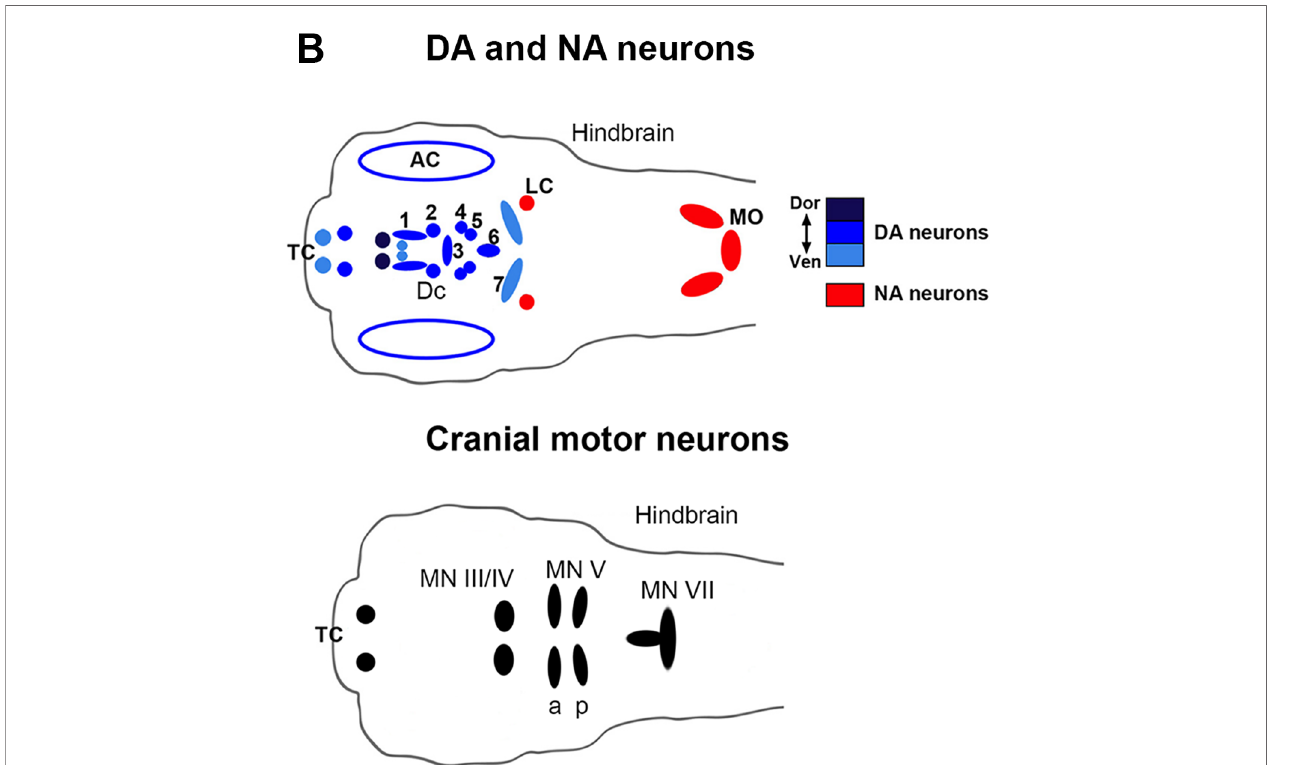
FIGURE 1 | Design of Small Molecule Screen in two phases. (A) Schematic depiction of primary screening and secondary screening procedure. We selected 32 small molecule inhibitors that target chromatin regulators. Zebra fi sh larvae were exposed to the small molecule inhibitors during distinct phases of DA and NA neuron development ranging from 24 to 72 hpf. We screened all compounds at different concentration to fi nd the optimal dosage for each small molecule inhibitor. During the primary screen we evaluated the effects of all selected small molecule inhibitors on DA and NA neurons by whole mount in situ hybridization (WISH) analysis of tyrosine hydroxylase expression. Small molecules that caused a dose-dependent change in DA and NA marker expression were considered a screening hit. For these compounds, we performed a secondary screen to evaluate DA and NA neurogenesis steps affected. (B) Schematic drawings of the distribution of DA and NA neurons (top, taken from Mahler et al., 2010), as well as of Isl1 expressing cranial motor neurons in the larval zebra fi sh brain at 96 hpf. DA neurons (blue, color intensity encodes dorsal to ventral position of DA groups as indicated) analyzed during the screening procedure reside in the olfactory bulb, subpallium (telencephalon, Tc), retina, pretectum (PrT) and ventral diencephalon (DC1 – 6) (Holzschuh et al., 2001; Rink and Wullimann, 2002). NA neurons (red) reside within the locus coeruleus (LC) and medulla oblongata (MO) area of the hindbrain. The analyzed Isl1 expressing cranial motor neurons reside within the telencephalon (Tc), the midbrain (MN II/IV) and the hindbrain (MN Va, Vp and MN VII) (Higashijima et al., 2000). AC, amacrine cells; DA, dopaminergic; DC, diencephalic; LC, locus coeruleus; MN, motor neuron cluster; MO, medulla oblongata; NA, noradrenergic; Tc,